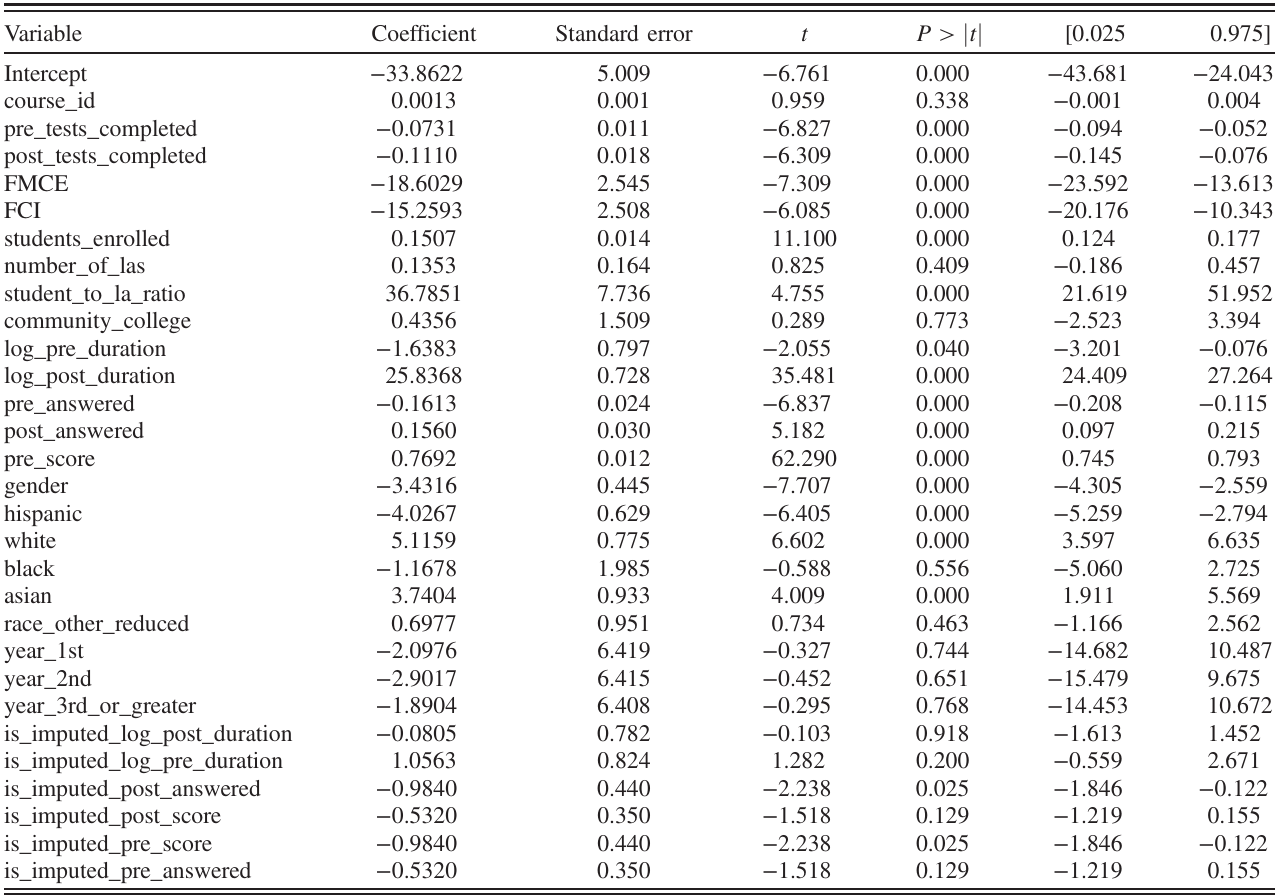
TABLE V. OLS coefficients for the OLS model presented in the LASSO